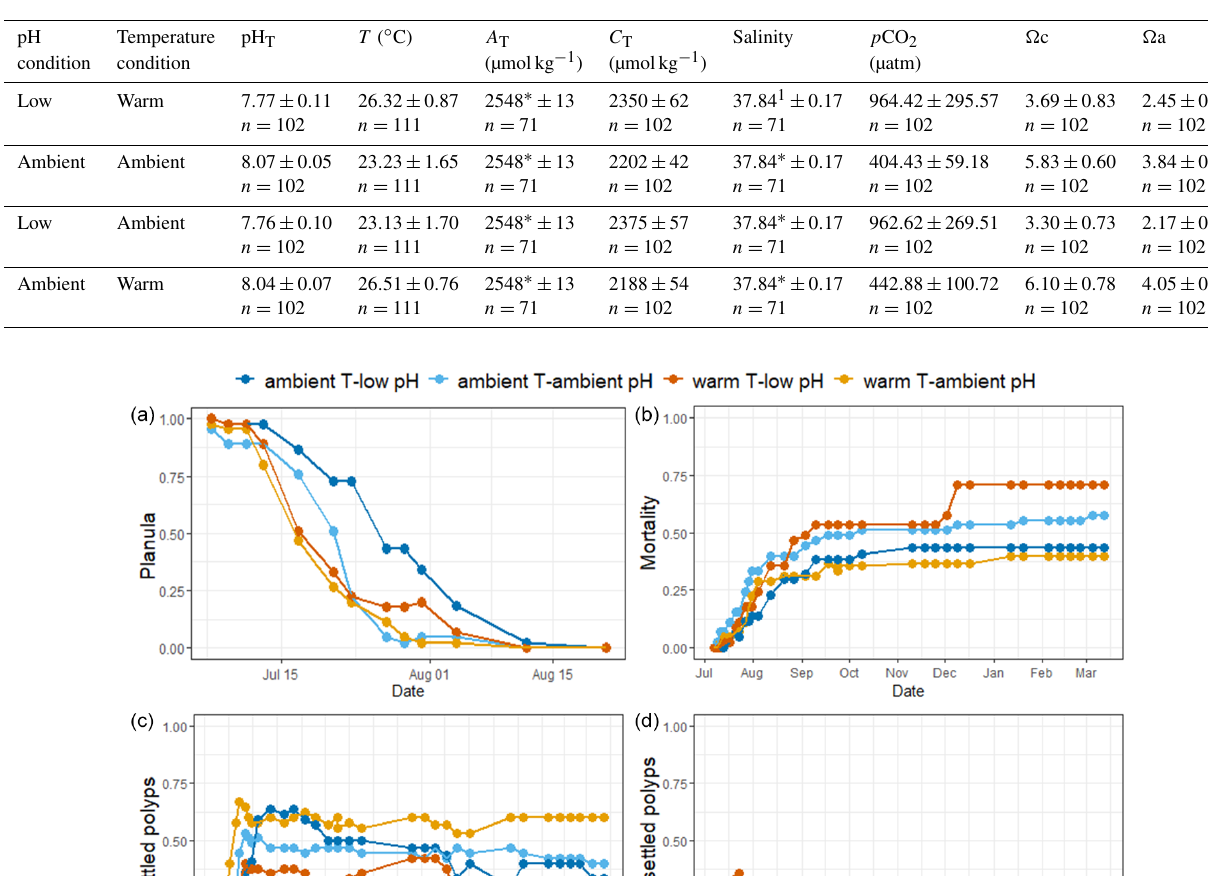
Table 1. Measured and estimated seawater physiochemical parameters of the two pH treatments in the experimental tanks for salinity ( S ), temperature ( T ), total alkalinity ( A T ), dissolved inorganic carbon ( C T ), pH T , p CO 2 , calcite ( (cid:127) c) and aragonite ( (cid:127) a) saturation. Values are means ± SD with the 25th and 75th percentiles. Calculated concentrations of C T , p CO 2 , (cid:127) c and (cid:127) a are shown. ∗ Parameters measured from discrete water samples. pH and temperature conditions are the experimental pH and temperature treatments.